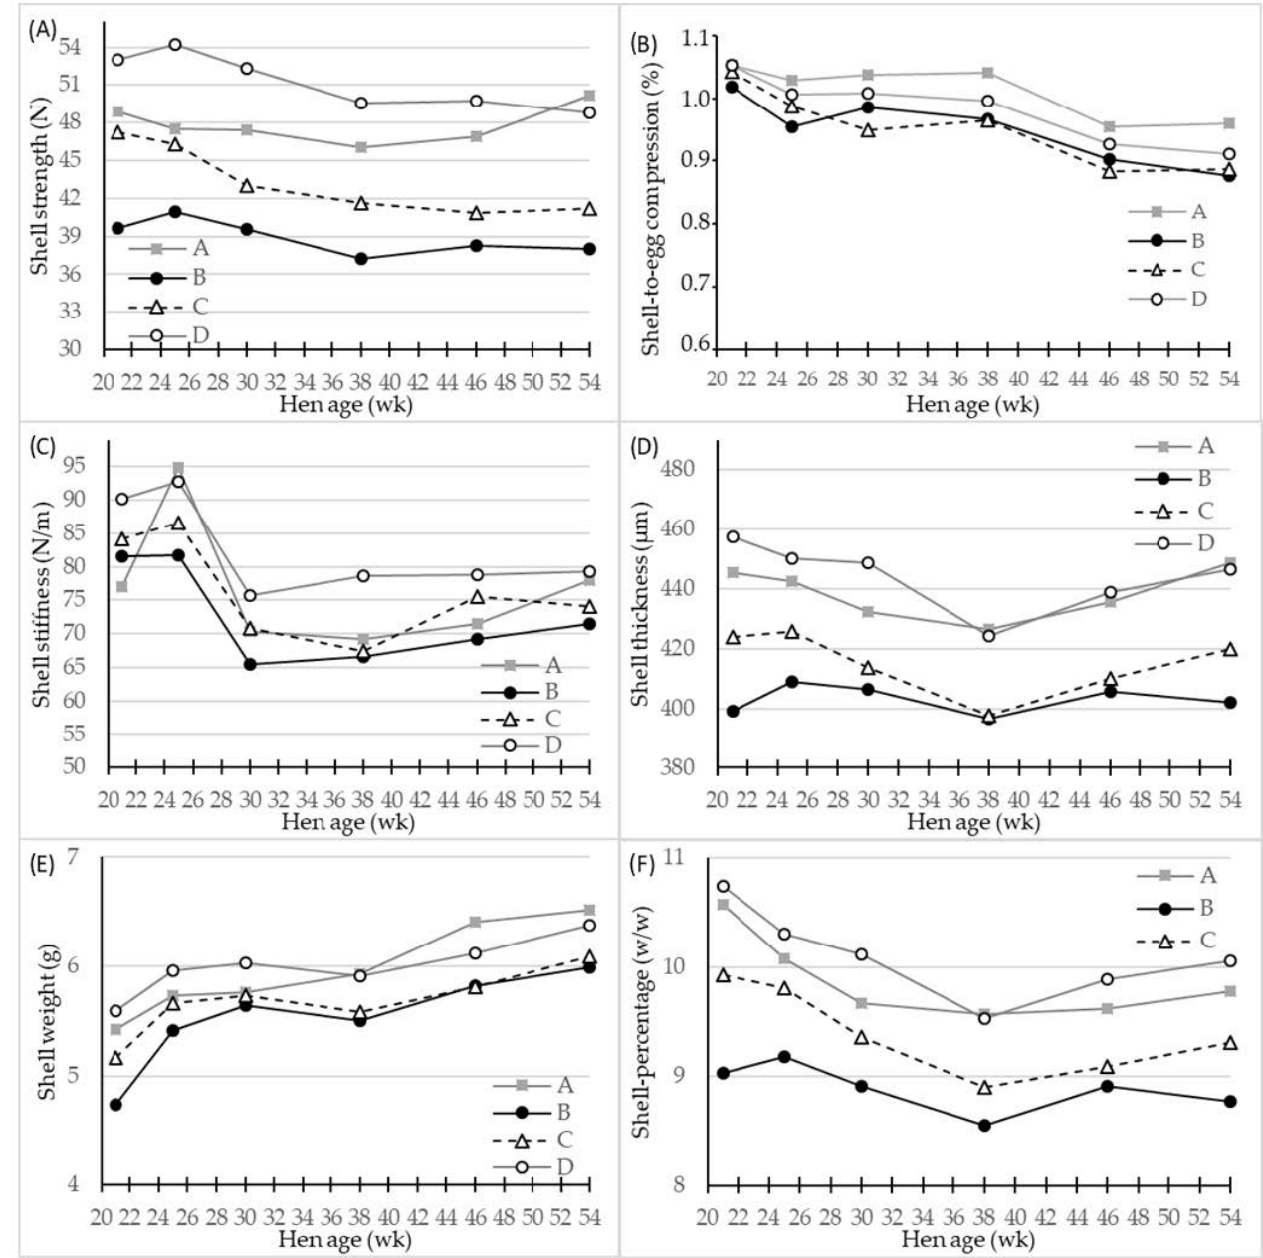
Figure 2. LS-means of shell parameters of four different hen genotypes ( A – D ) as differentiated by hen age (week). ( A ) shell strength (N) at compression, ( B ) shell-to-egg-compression (%), ( C ) shell stiffness (N/m), ( D ) shell thickness (µm) at equator, ( E ) shell weight (g) after air drying, and ( F ) shell percentage ( w / w ), n = 30 for genotype A and 45 for genotypes B, C and D. In the original article, there was a mistake in Figure 3 as published and the legend for Figure 3. The correct legend and corrected Figure 3 appear